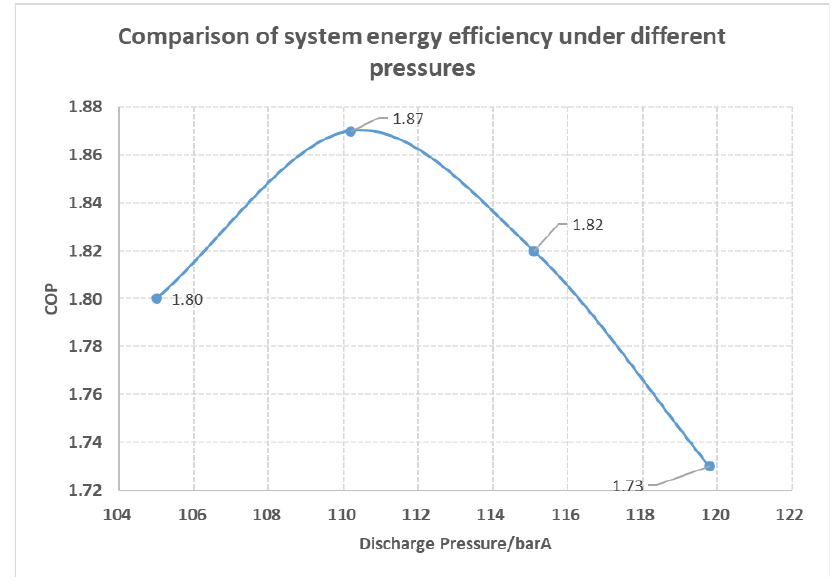
Figure 4. Change rule of COP under different discharge pressures at 40